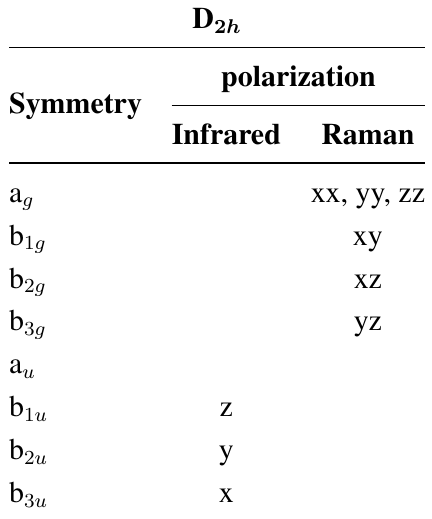
Table 2. The analysis of the symmetry species and their polarization-dependent activity for the D point group of the TMTTF 2 h